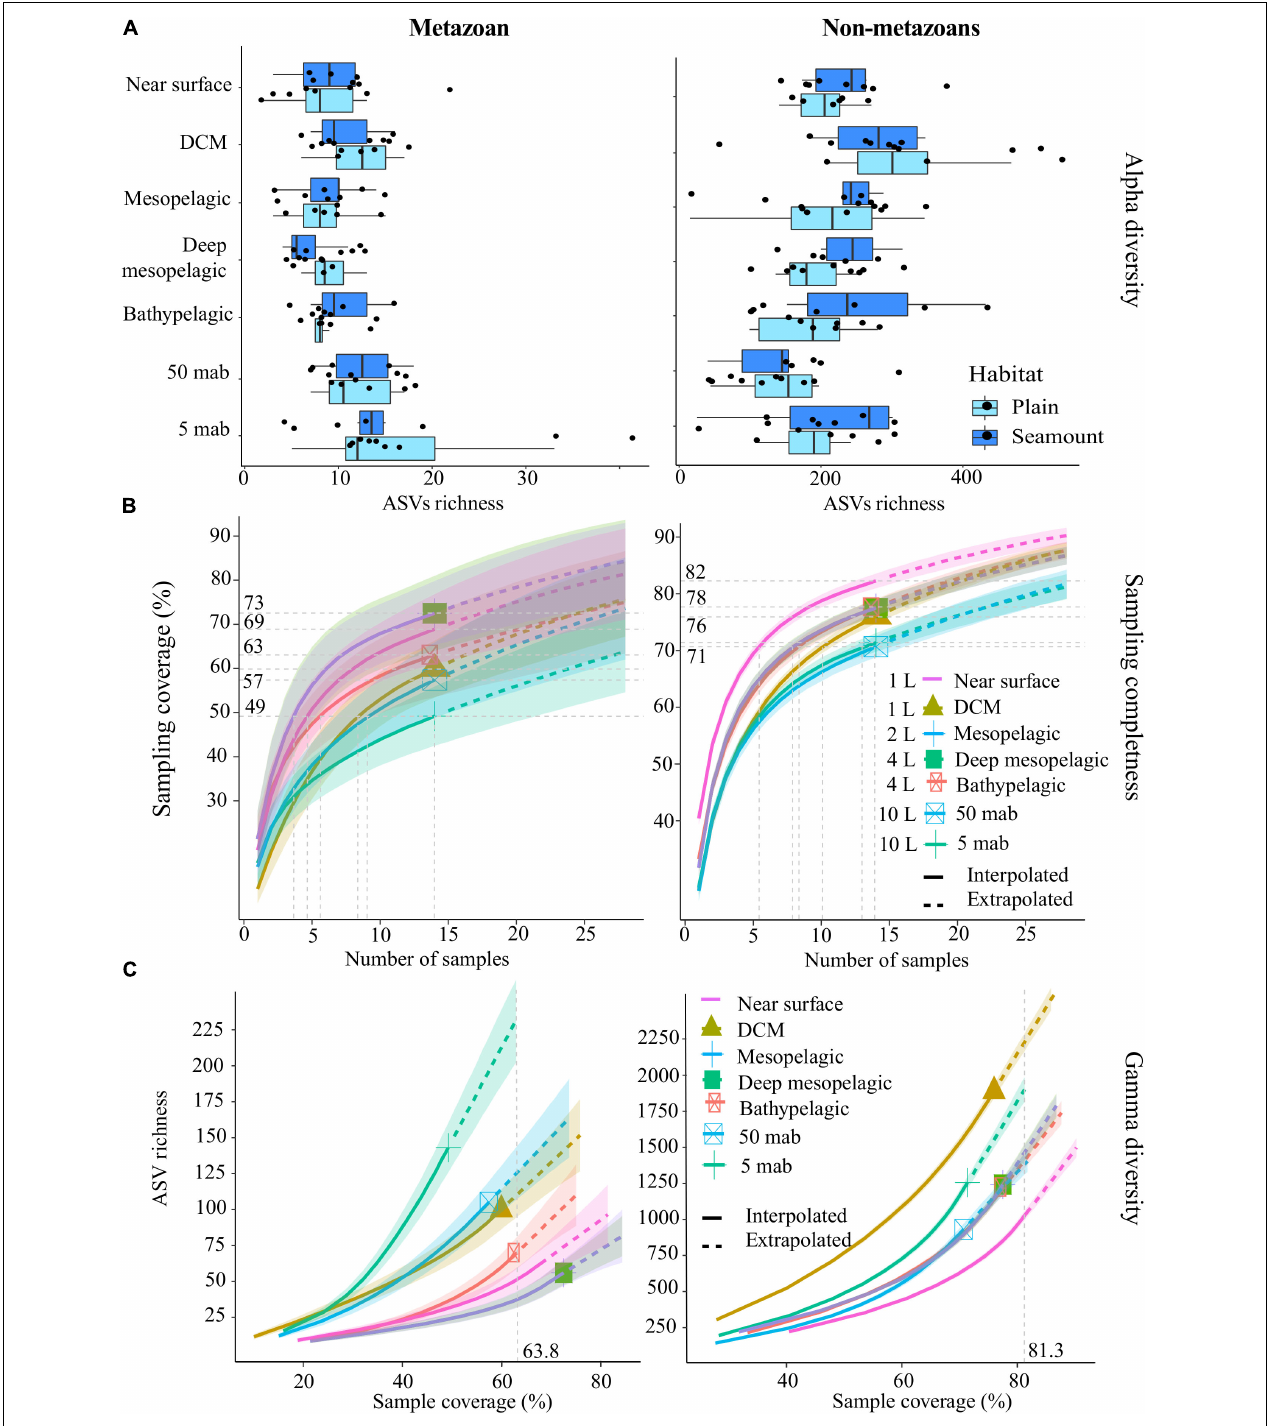
FIGURE 3 | Alpha-diversity, sampling completeness and gamma-diversity across the water column for both metazoans and non-metazoans. (A) Box-plot of mean amplicon sequence variant (ASV) richness observed per sample, within each habitat type (abyssal plains, seamounts). (B) Sampling coverage achieved across the water column, with seawater volumes filtered at each depth as listed. Horizontal gray dotted lines indicate maximum interpolated sampling coverage values for each water column depth horizon. (C) Estimated ASV richness as a function of sampling coverage (Chao2 estimator), across the water column. The vertical dotted gray line represents sample completeness at base coverage, defined as the highest coverage value between minimum extrapolated values and maximum interpolated values. DCM, deep chlorophyll maximum; mab, meters above bottom. For (B,C) , shaded colored areas indicate the 95% confidence intervals obtained by a bootstrap method based on 200